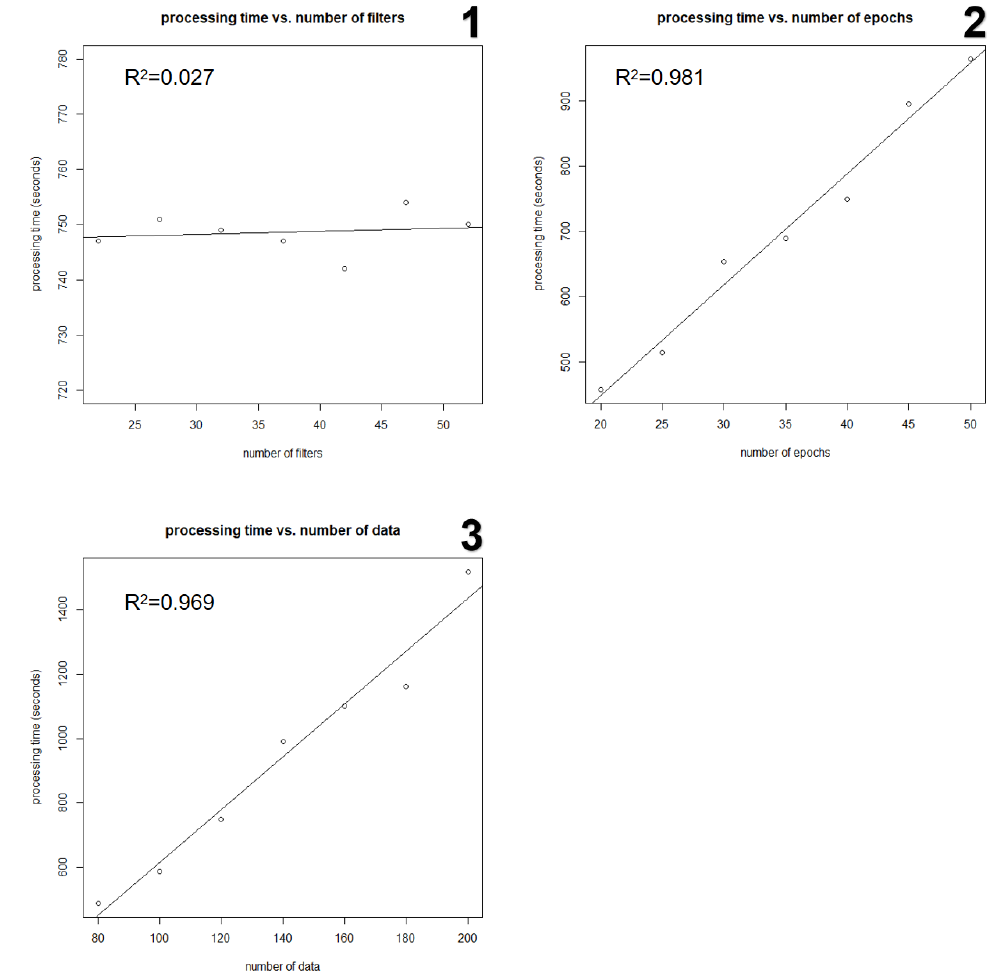
Figure 5. Changes of processing time based on different numbers of parameters: Plot 1 , Changes of processing time based on different numbers of filters; Plot 2 , Changes of processing time based on different numbers of epochs; Plot 3 , Changes of processing time based on different numbers of data.